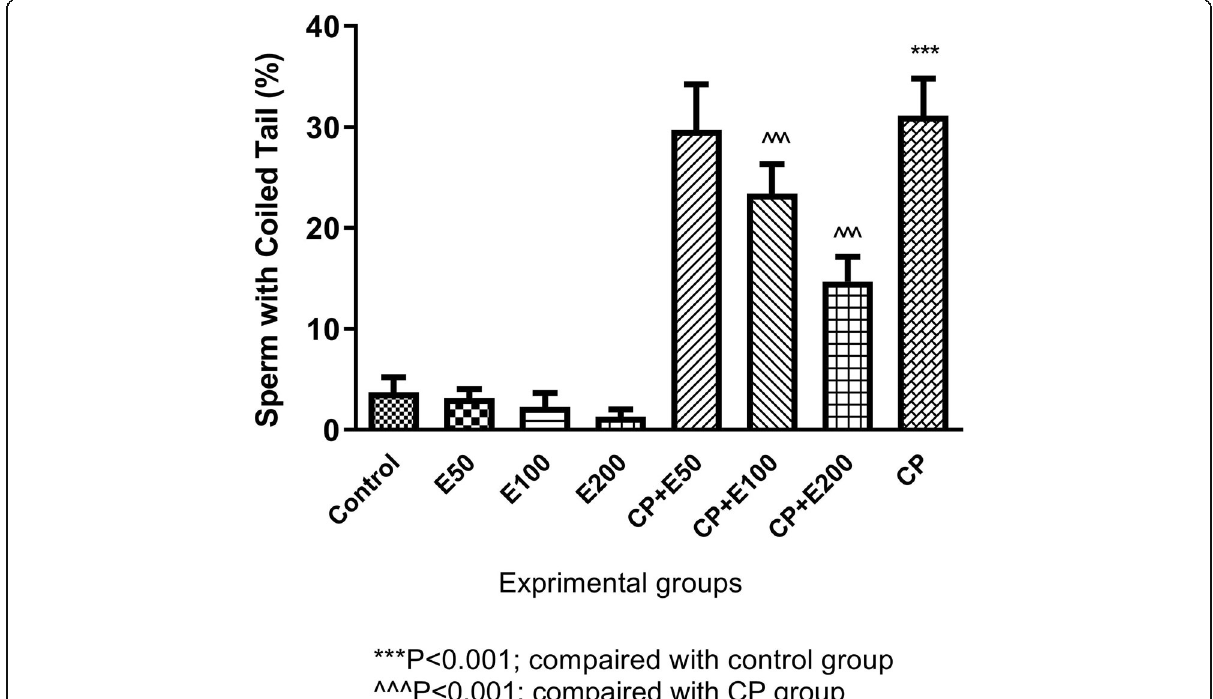
Fig. 8 The effect of Allium atroviolaceum L. extract (E) on the number of the sperm with coiled tail count in cyclophosphamide (CP)-treated mice